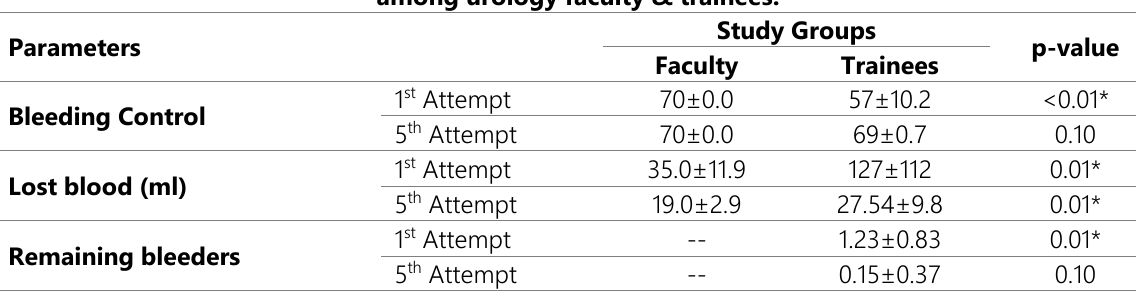
Table 2: Comparative findings of Simulative TURP-Bleeding Control among urology faculty &